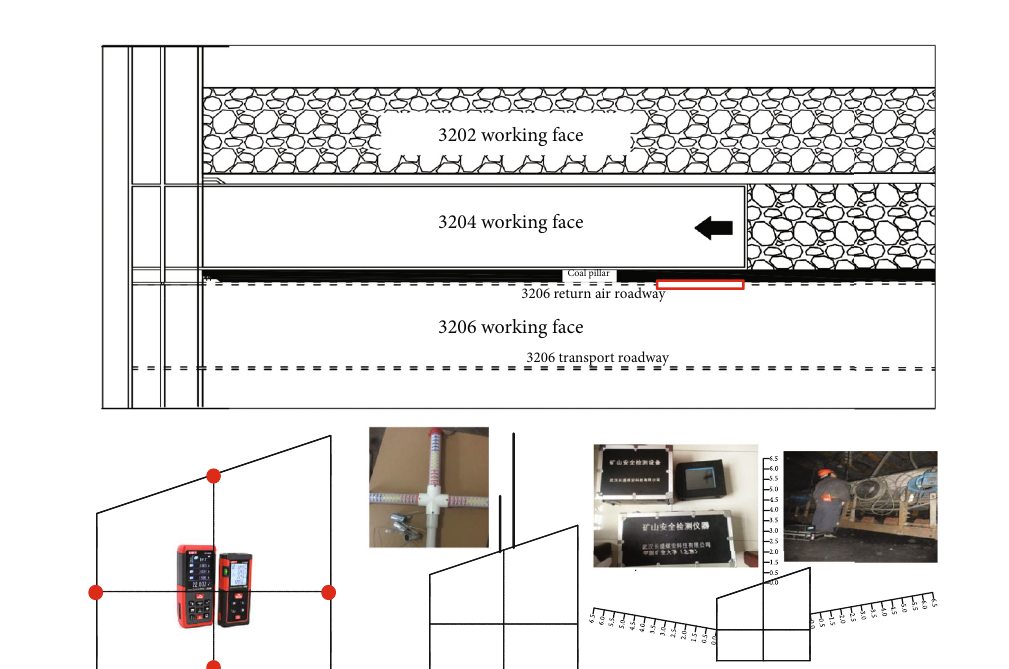
Figure 17: Monitoring of the roadway stability.